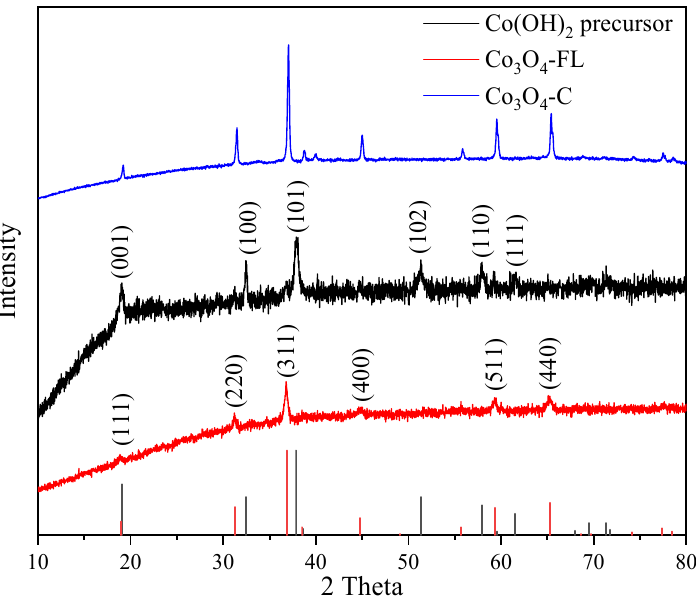
Figure 1. XRD patterns of the as-prepared Co(OH) 2 precursor, Co 3 O 4 -FL, and Co 3 O 4 -C.